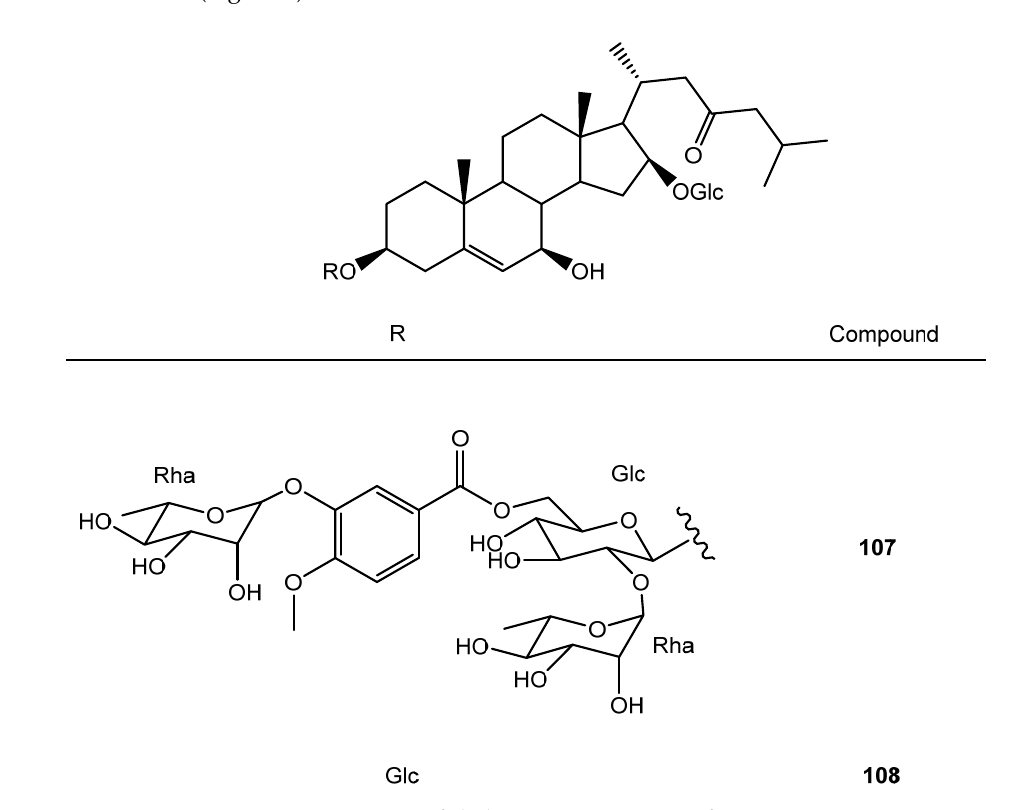
Figure 9. Structure of cholestane-type saponins from Yucca.